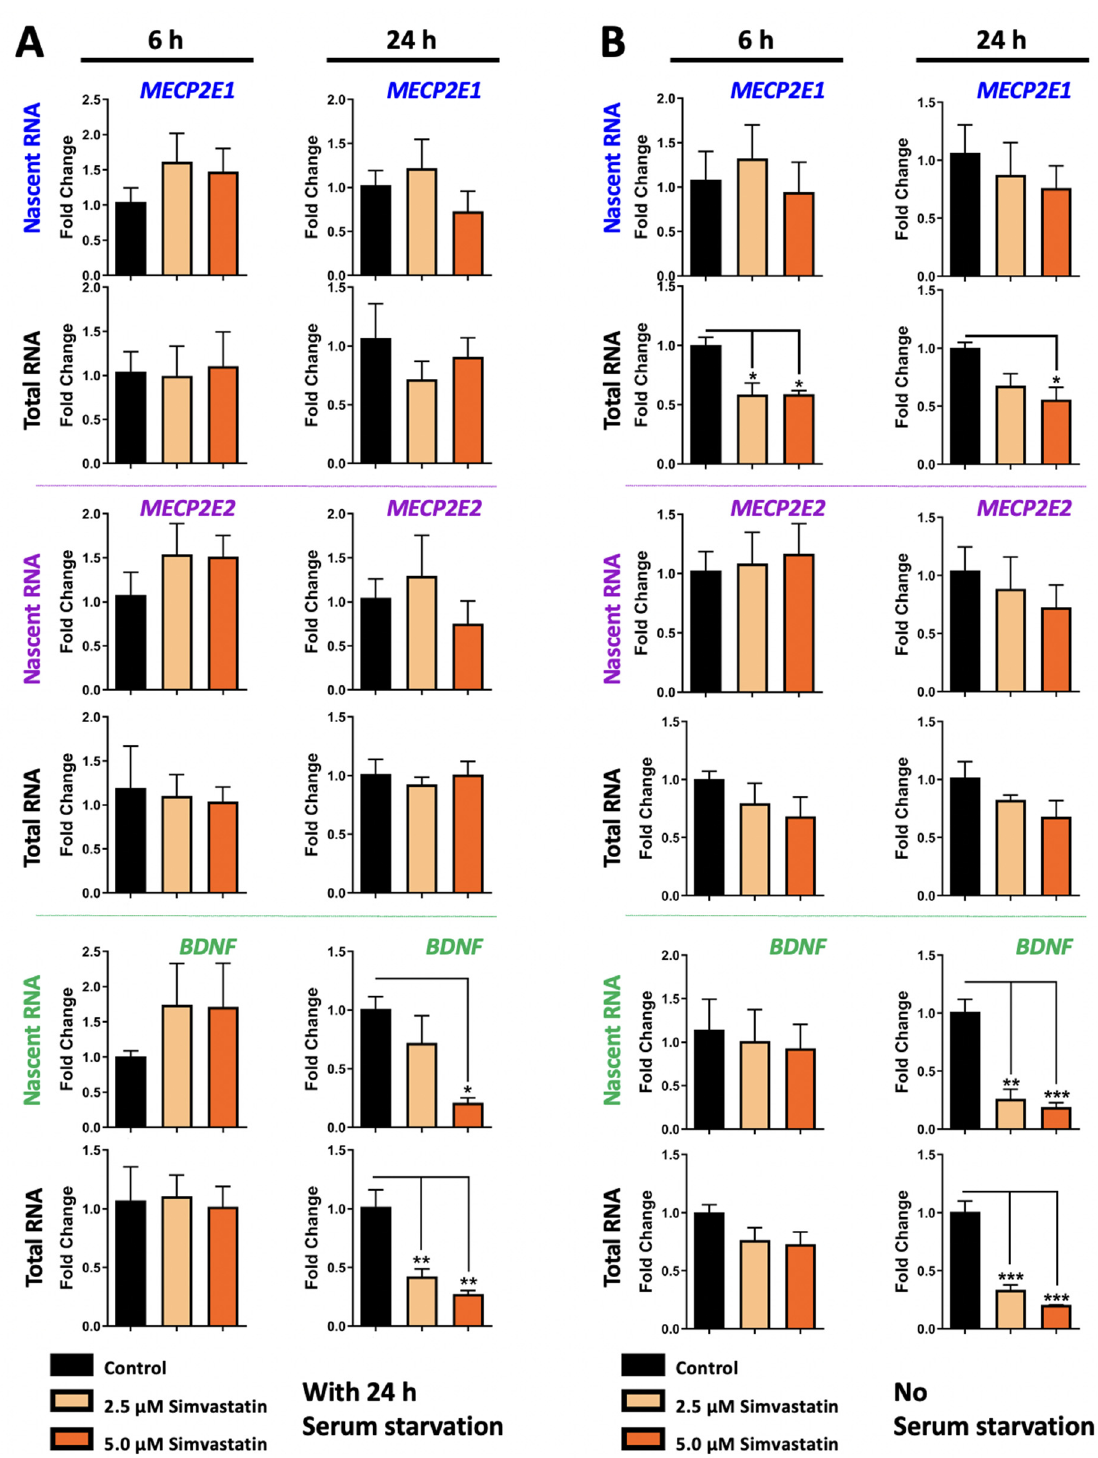
Figure 4. Transcriptional effect of simvastatin on MECP2E1-E2 and BDNF in Daoy cells under the condition with and without serum starvation. ( A ) Daoy cells were serum-starved for 24 h prior to drug treatment with 2.5 and 5.0 µ M simvastatin. Samples were collected at 6 and 24 h and gene transcripts were analyzed by RT-PCR for MECP2E1 , MECP2E2 , and BDNF . C T values were normalized to the housekeeping gene GAPDH and fold change was determined relative to the average control. N = 3 ± SEM. Fold change values were analyzed by one-way ANOVA followed by Tukey’s multiple comparisons test, * p < 0.05, ** p < 0.01, and *** p < 0.001. ( B ) Similar to A, but Daoy cells were subjected to the same drug treatment, without prior serum starvation.